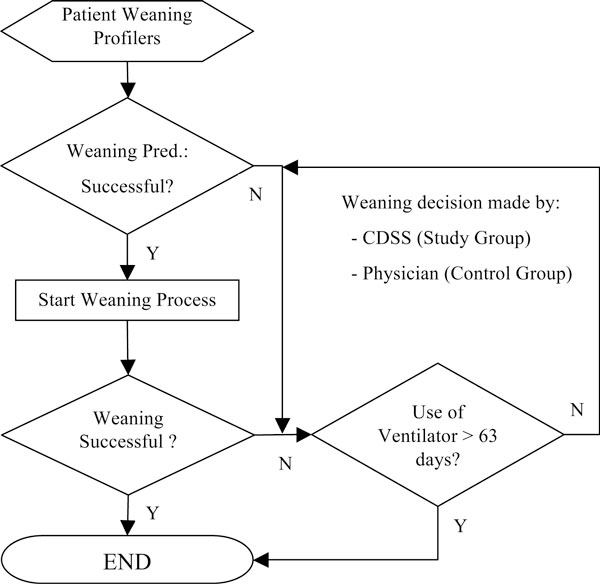
Experimental procedure.